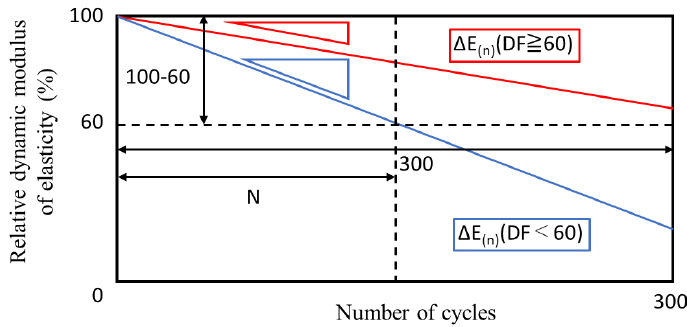
Figure 5. Relative dynamic elastic modulus decreasing per cycle.